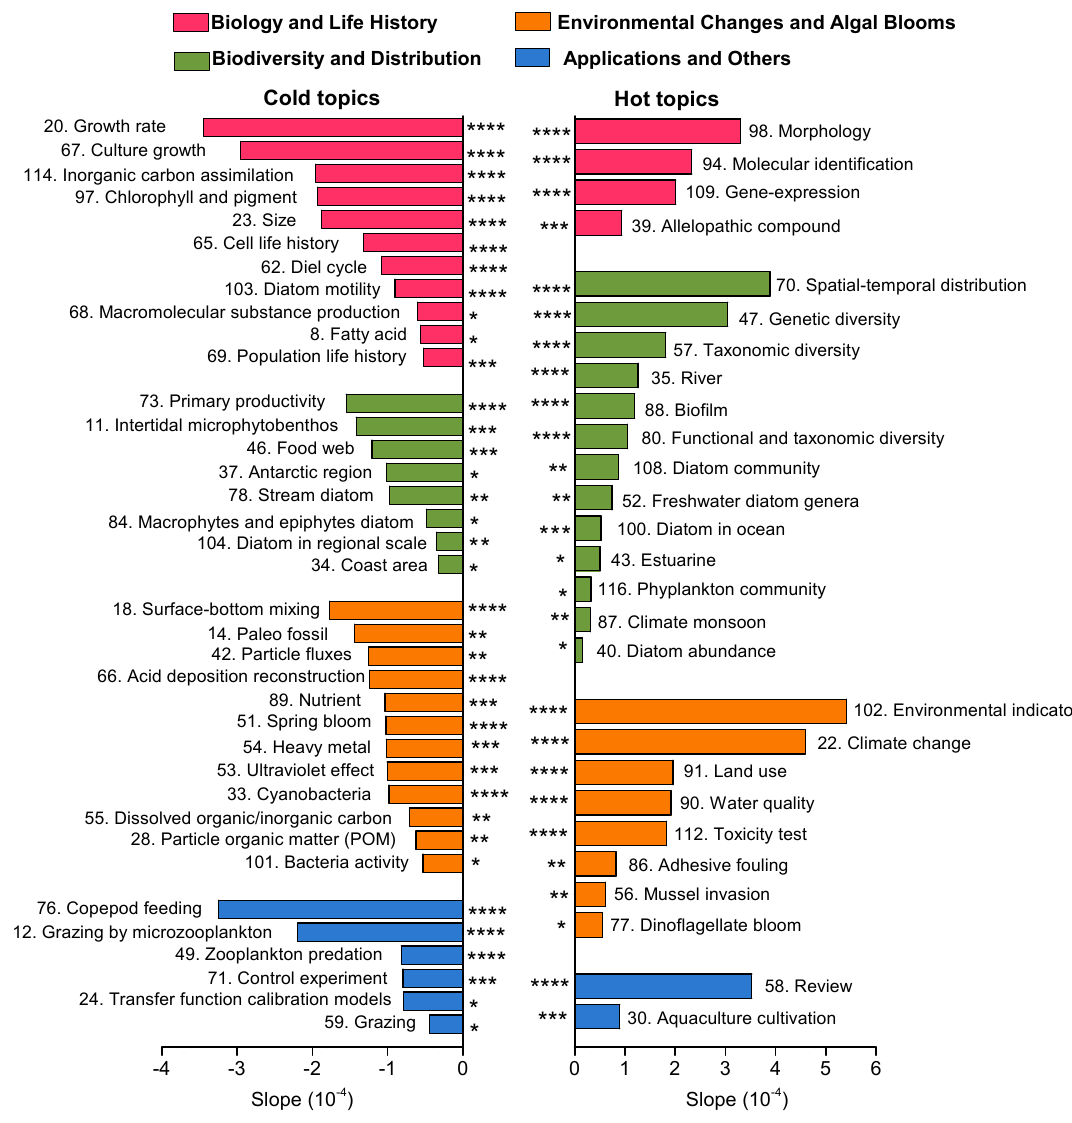
Figure 5. The significant cold and hot topics sorted by the slope of the linear models for the four broader themes. (* represents p = 0.05, ** represents p = 0.01, *** represents p = 0.001, and **** represents p = 0.0001).